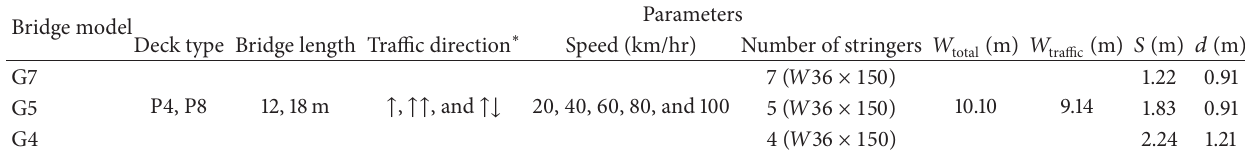
Table 2: Bridge model parameters.